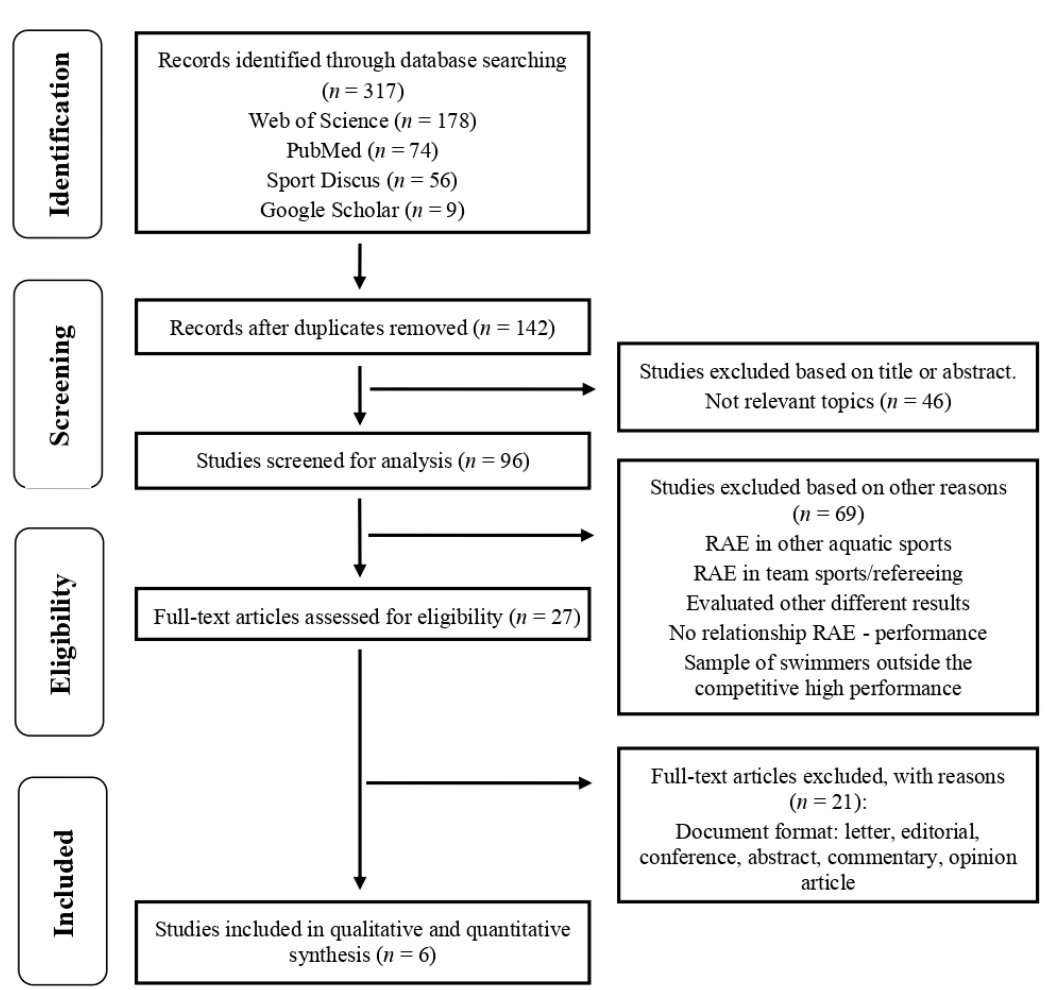
Figure 1. Flow chart for screening and selection according to the Preferred Reporting Items for Systematic Reviews and Meta-Analyses (PRISMA).